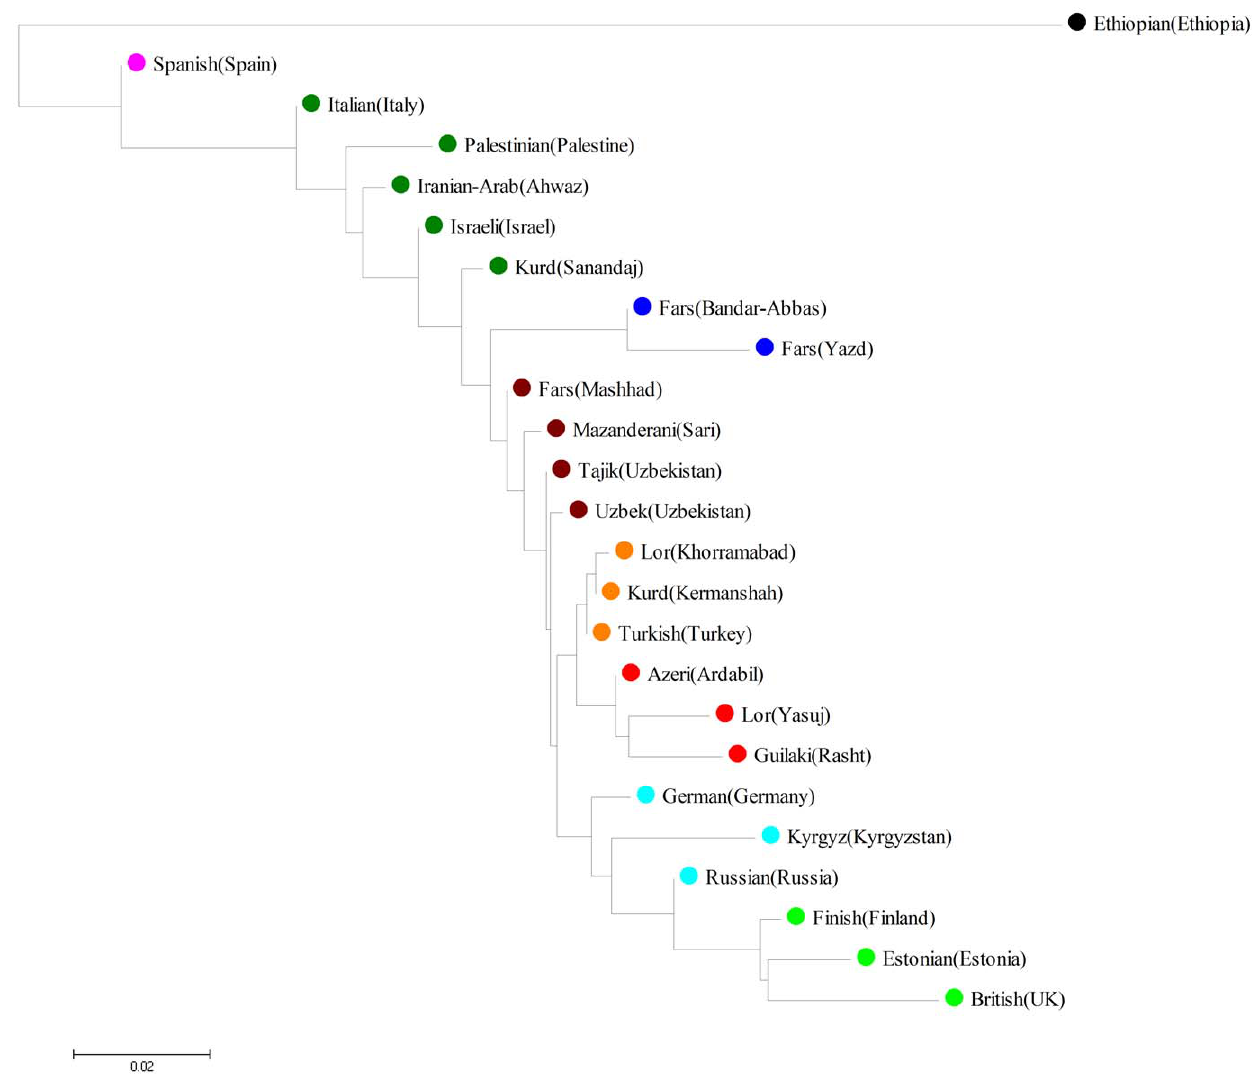
Figure 3. Neighbor-joining tree based on pairwise F ST values generated from hpEurope population.